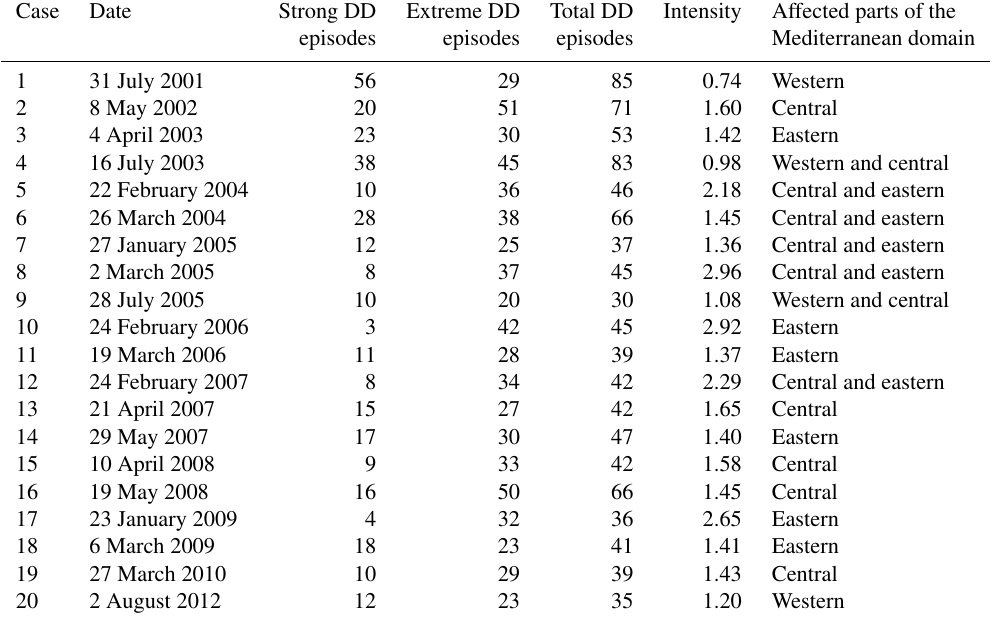
Table 1. List of the Mediterranean desert dust outbreaks which have been identified within the geographical limits of the MSD based on the satellite algorithm. In addition, the number of strong, extreme and total (strong plus extreme) DD episodes (number of satellite grid cells at 1 ◦ × 1 ◦ spatial resolution where a DD episode has been identified), the regional intensity (in terms of AOD 550nm ) calculated from the total DD episodes as well as the dust-affected parts of the Mediterranean domain are